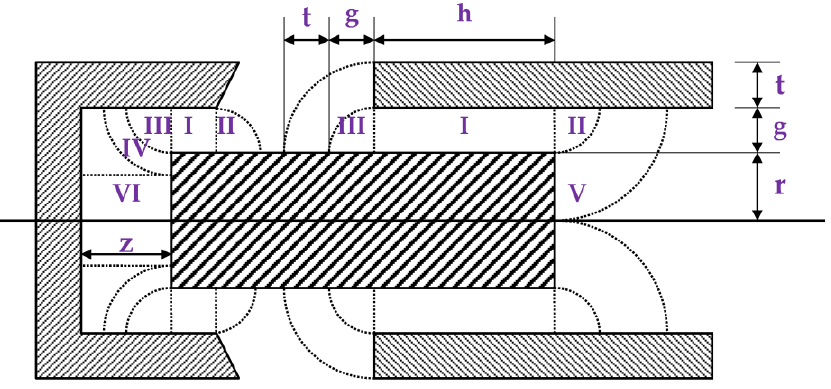
Figure 6. Six types of simplified magnetic flux paths.